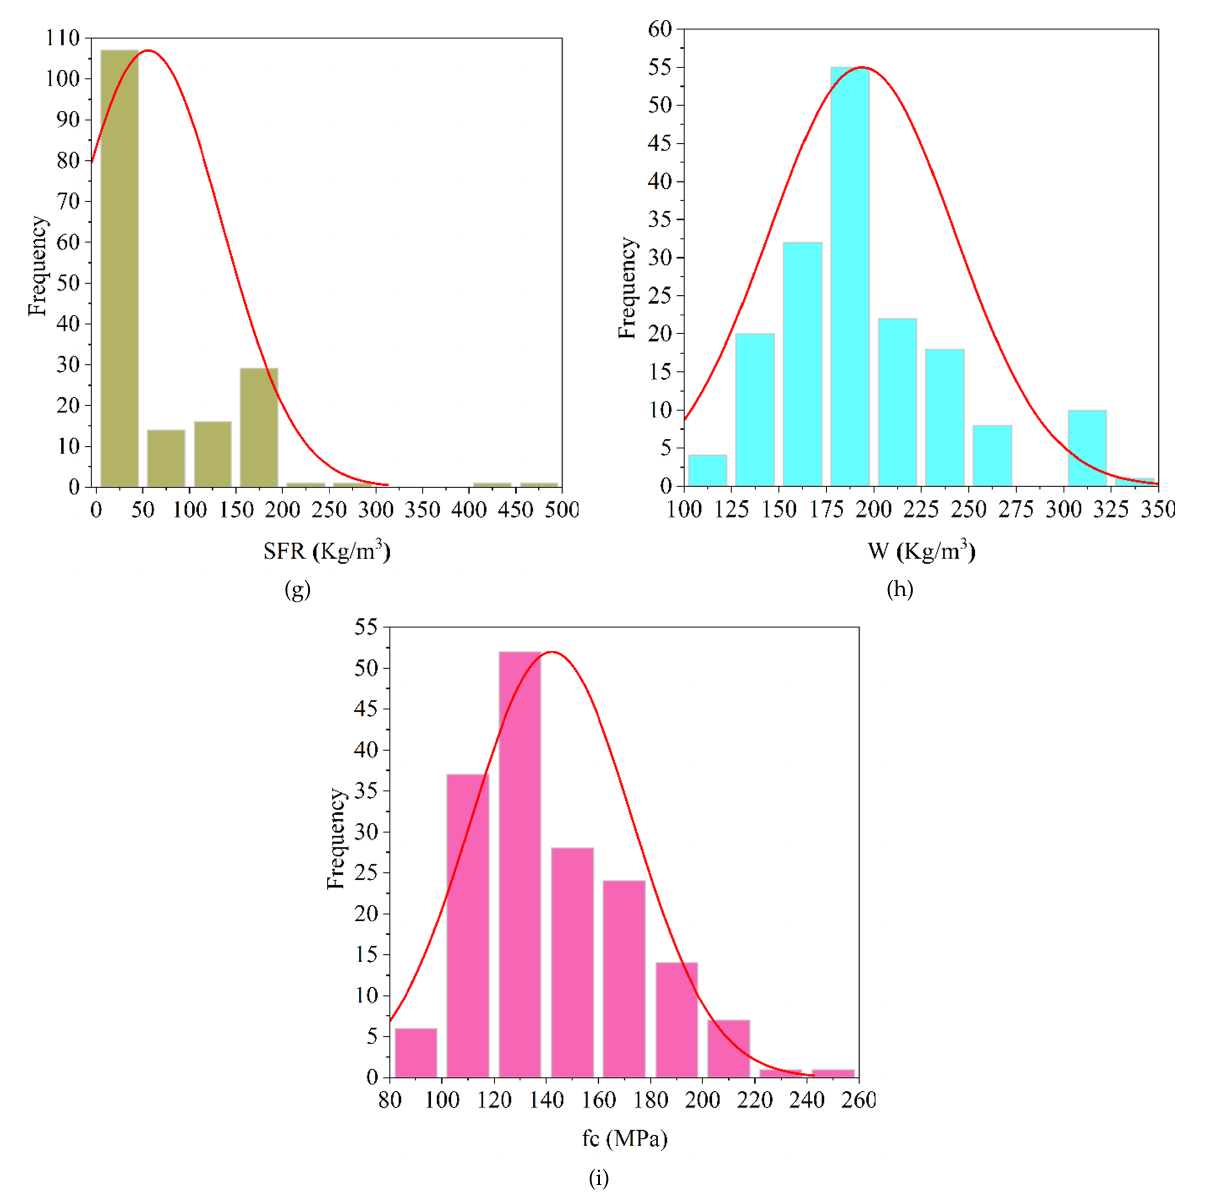
Fig. 1. Distribution of input variables